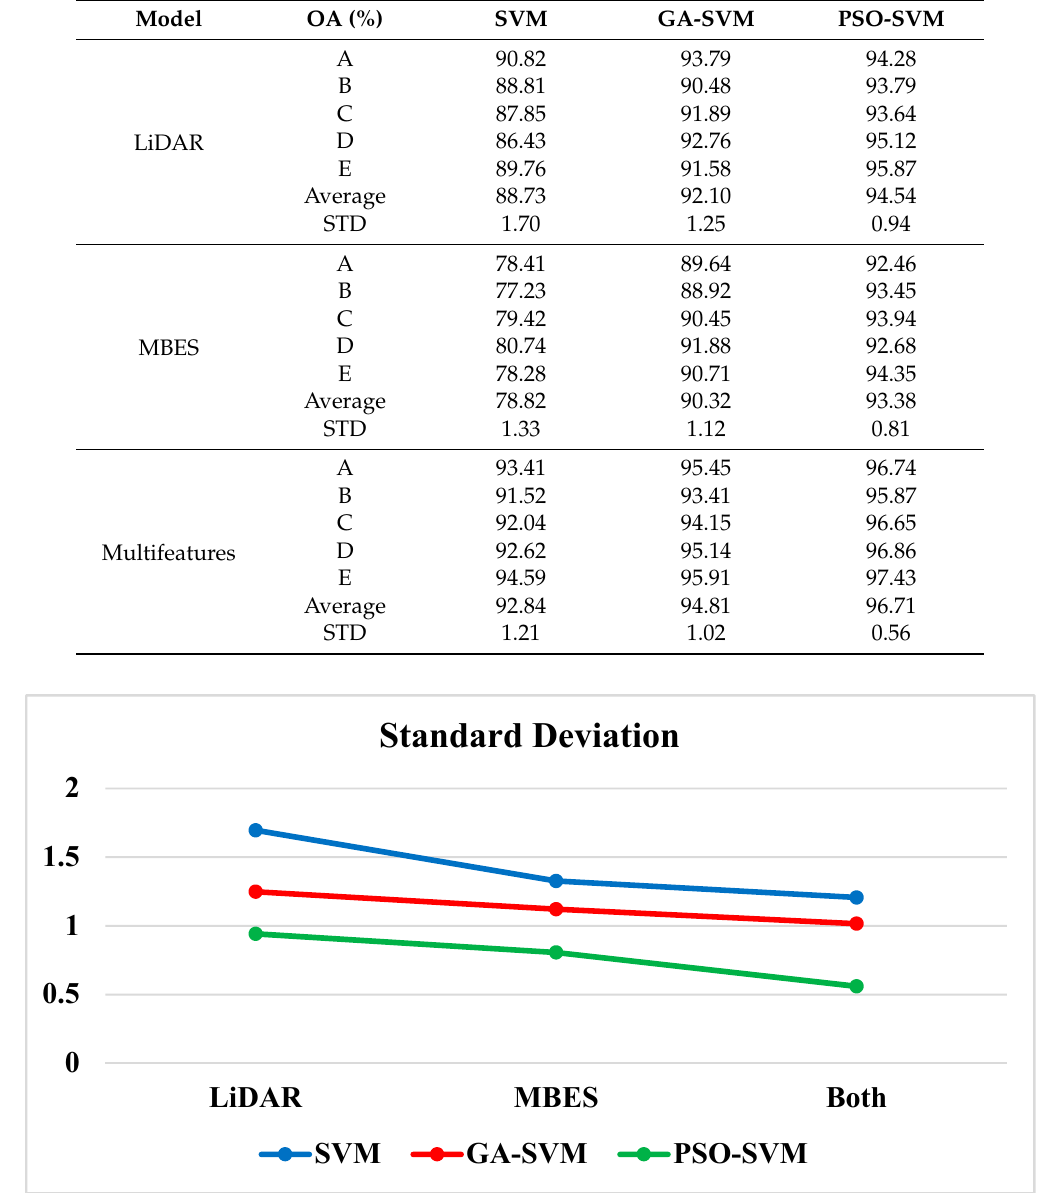
Figure 9. Standard deviations of different models based on five-fold cross validation.